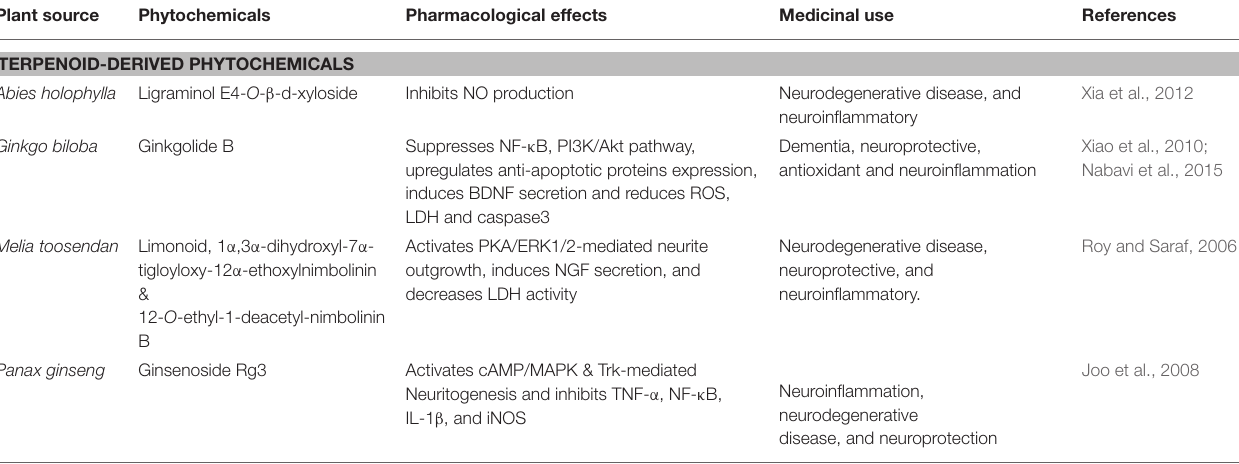
TABLE 3 | Terpenoid-derived phytochemicals that affect Alzheimer’s disease.